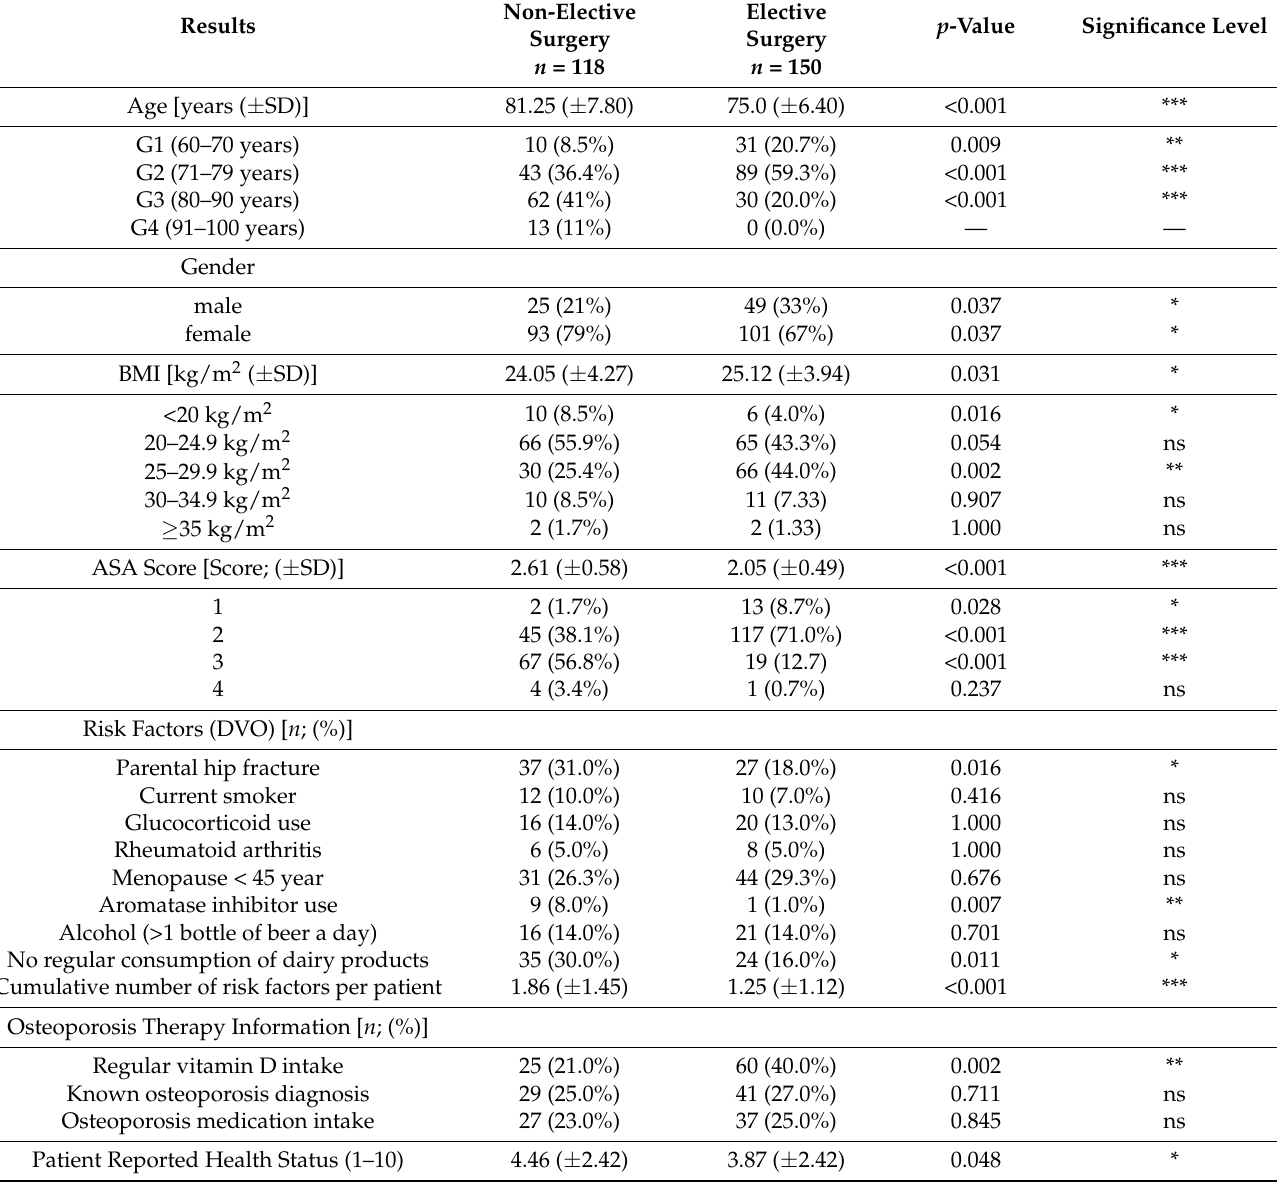
Table 1. Demographic data and characteristics of the study population; Body Mass Index (BMI); Physical Status Classification System (ASA); Dachverband für Osteologie (DVO). *